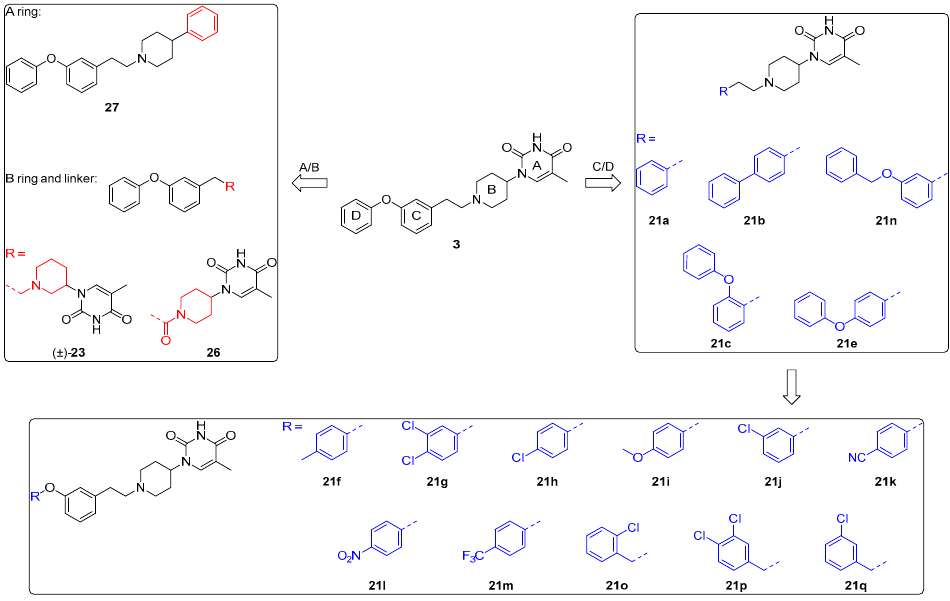
Figure 2. An overview of the synthesized compounds 3 , 21a - 21q , 26 and 27 in this